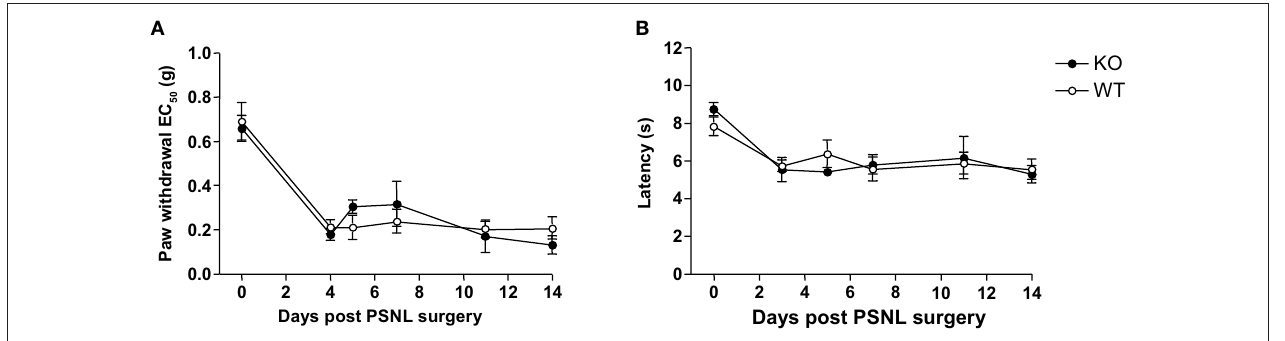
(B) Signifi cant thermal hypersensitivity was observed in Glra3 − / − mice and wild- type mice at all days following surgery ( p < 0.001) compared with contralateral controls ( n = 6). No differences were observed between genotypes. Data are presented as mean ± SEM and analysed using two-way repeated measures ANOVA, Bonferroni post hoc